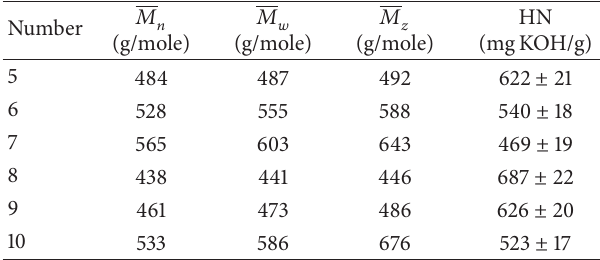
Table 6: Molar masses of the obtained polyols determined by means of GPC